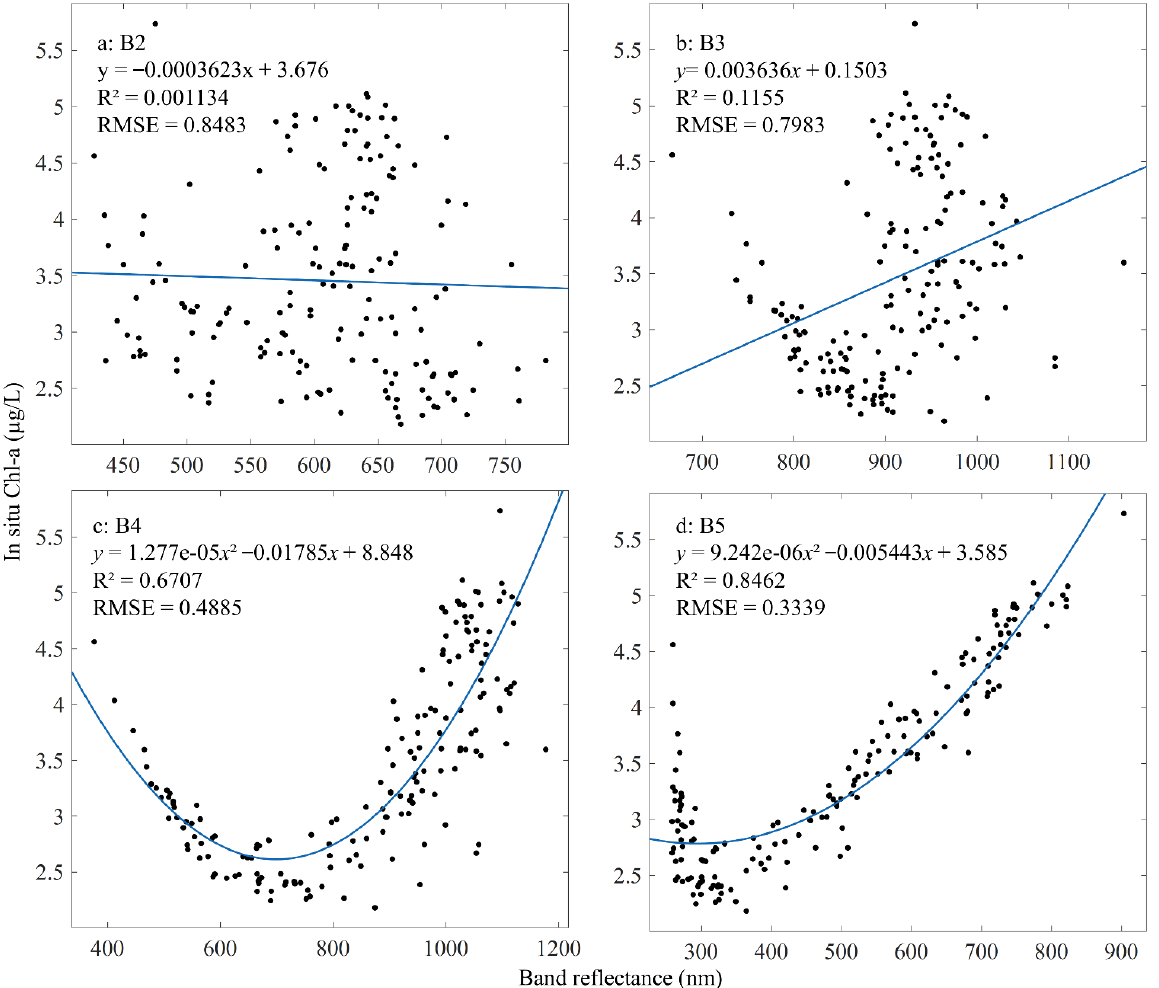
Figure 2. Correlation between the band value retrieved from PMS image after atmosphere correction and sampled Chl-a. ( a ) B2 (blue band); ( b ) B3 (green band); ( c ) B4 (red band); ( d ) B5 (NIR band).